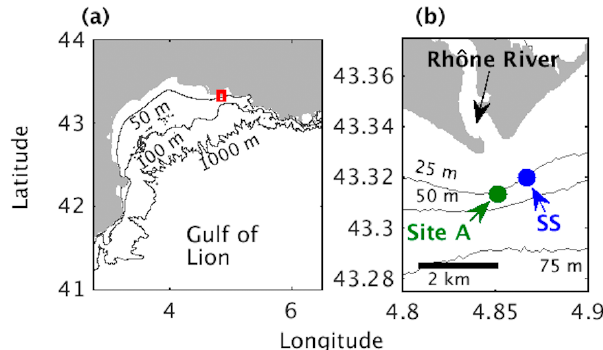
Figure 1. (a) Red box indicates location of panel (b) in the Gulf of Lion. (b) Dots indicate our study site (SS; blue), i.e., the Mesurho station (Pairaud et al., 2016), and Pastor et al.’s (2014) Site A (green) offshore of the Rhône River. Bathymetric data (black lines) were obtained from the European Marine Observation and Data Network. Coastline data were obtained from the US National Oceanic and Atmospheric